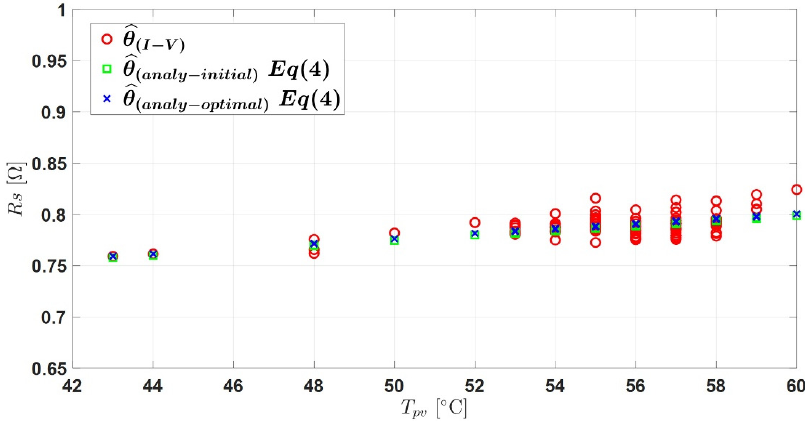
Figure 16. Evolution of R s for constant G poa . Table 8 . Extracted reference values for constant 𝐺 (cid:3043)(cid:3042)(cid:3028) .